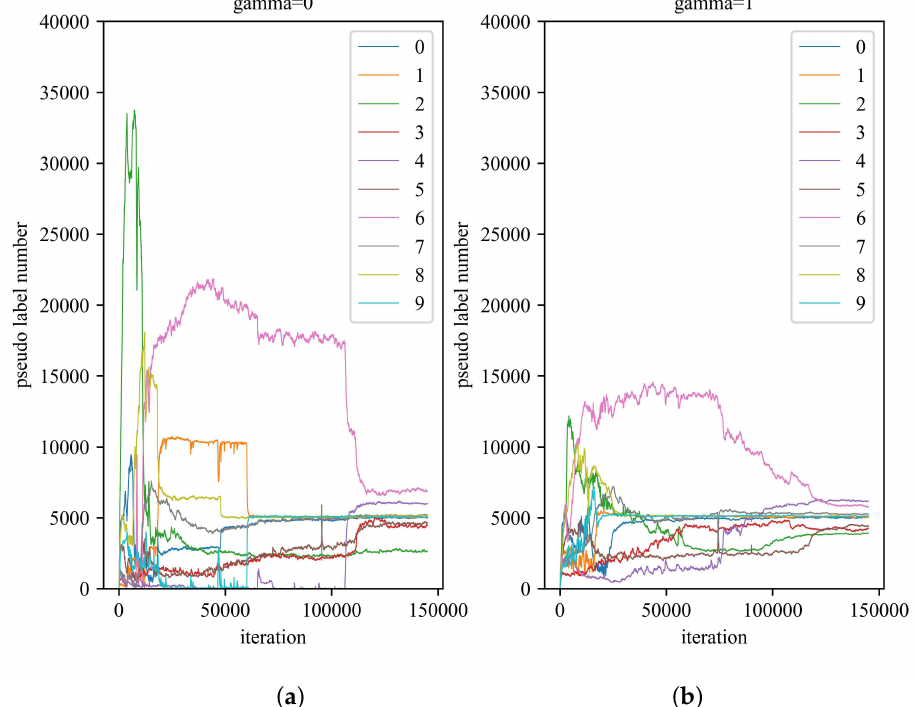
Figure 4. Ablation study on the use of focal loss. The number of pseudo labels generated of each class for the first 150,000 iterations ( a ) When gamma = 0 (i.e., not using focal loss). ( b ) When gamma = 1. The numbers in the figure legend represent the 10 classes in the CIFAR-10